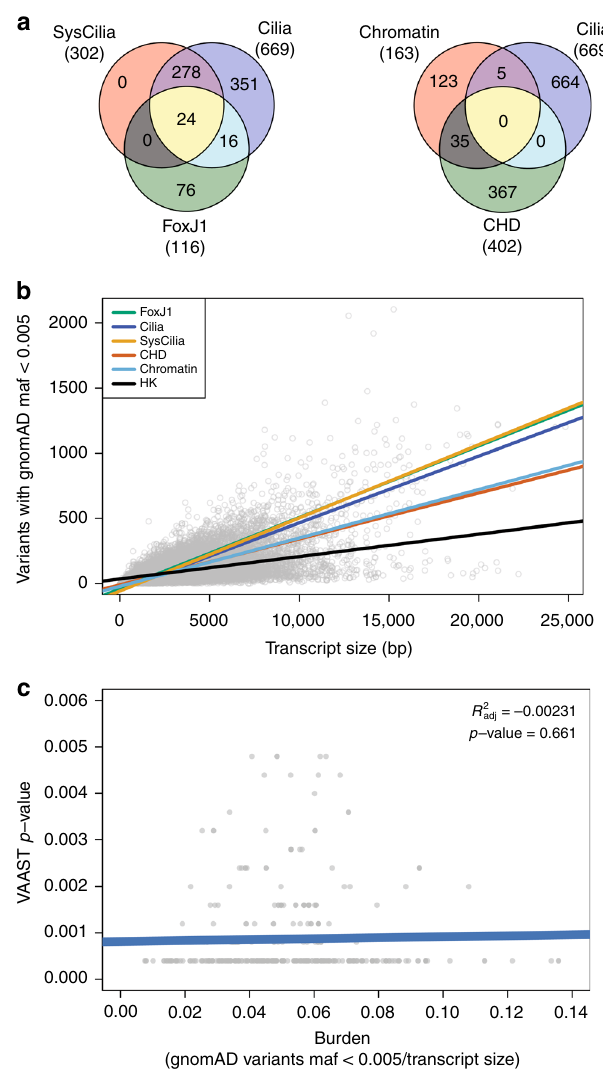
Fig. 2 Cilia, chromatin, and CHD gene lists and burden analysis. a The relationships among fi ve major gene sets used for enrichment analysis. Structural cilia (SysCilia) genes are a subset of all Cilia list genes. The CHD gene list has no overlap with cilia genes, and chromatin genes have only 3% overlap with cilia genes. b Gene burden by gene list. GnomAD-based gene- burden estimates (gray circles) are plotted as a function of transcript size. Regression lines for the genes contained in each major gene set are shown. The positive slopes indicate that, in general, large genes have higher burden than small genes. Cilia and FoxJ1-responsive genes show a higher rate (steeper slope) of increase in burden with gene size than do CHD or chromatin genes. Housekeeping genes have lower overall burden. c VAAST p values estimates are not affected by gene length or gene-burden. VAAST p values for damaged genes (gray dots) are plotted as a function of gene burden. The regression line (blue) shows the relationship between the VAAST p value estimates for damaged genes found in CHD probands and gene burden normalized by transcript size. No signi fi cant relationship between the number of damaged genes discovered nor magnitude of the p value as a function of gene burden is observed (coef fi cient of variation ( R 2 adj ) = − 0.00231, p value ≥ 0.66, linear-model F gene list. We note that the gene lists used here are non- exhaustive, but encompass many genes characteristic of, or ontologically linked to, each category or pathway. Genes utilized